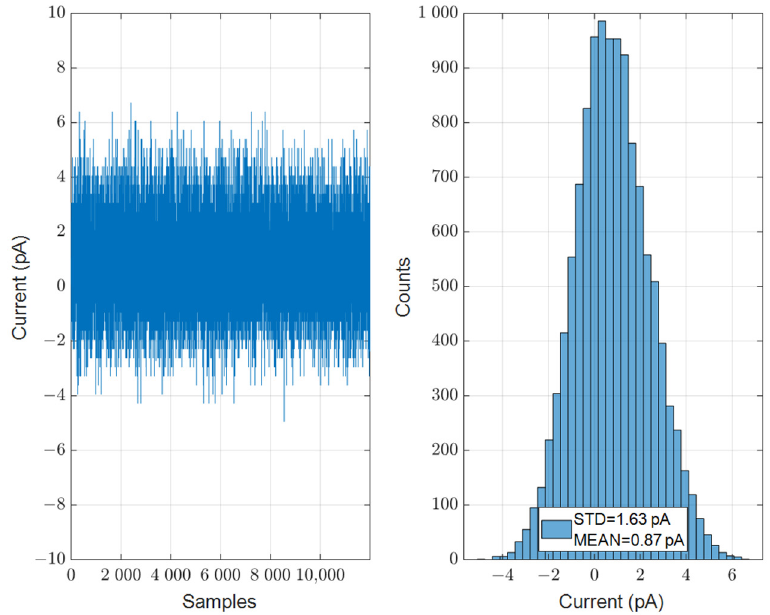
Figure 4. Histogram of the current meter noise signal. In this test, the input of the electrification current is not generated by phenomena. To the left is the measured signal, to the right is the noise histogram.